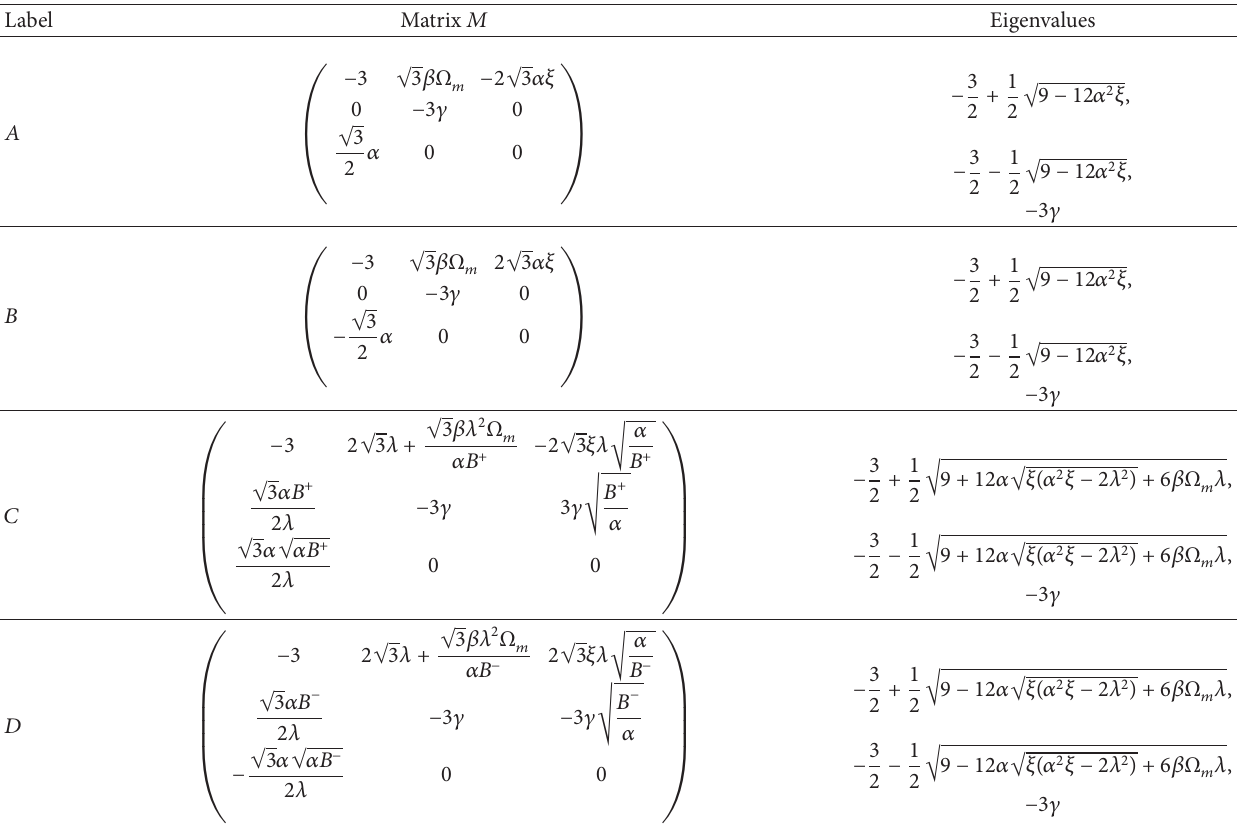
Table 2: The eigenvalues of the linearization matrices corresponding to the critical points. Here 𝐵 + = (𝛼𝜉 + √𝜉(𝛼 2 𝜉 − 2𝜆 2 )) and 𝐵 − = (𝛼𝜉 − √𝜉(𝛼 2 𝜉 − 2𝜆 2 ))